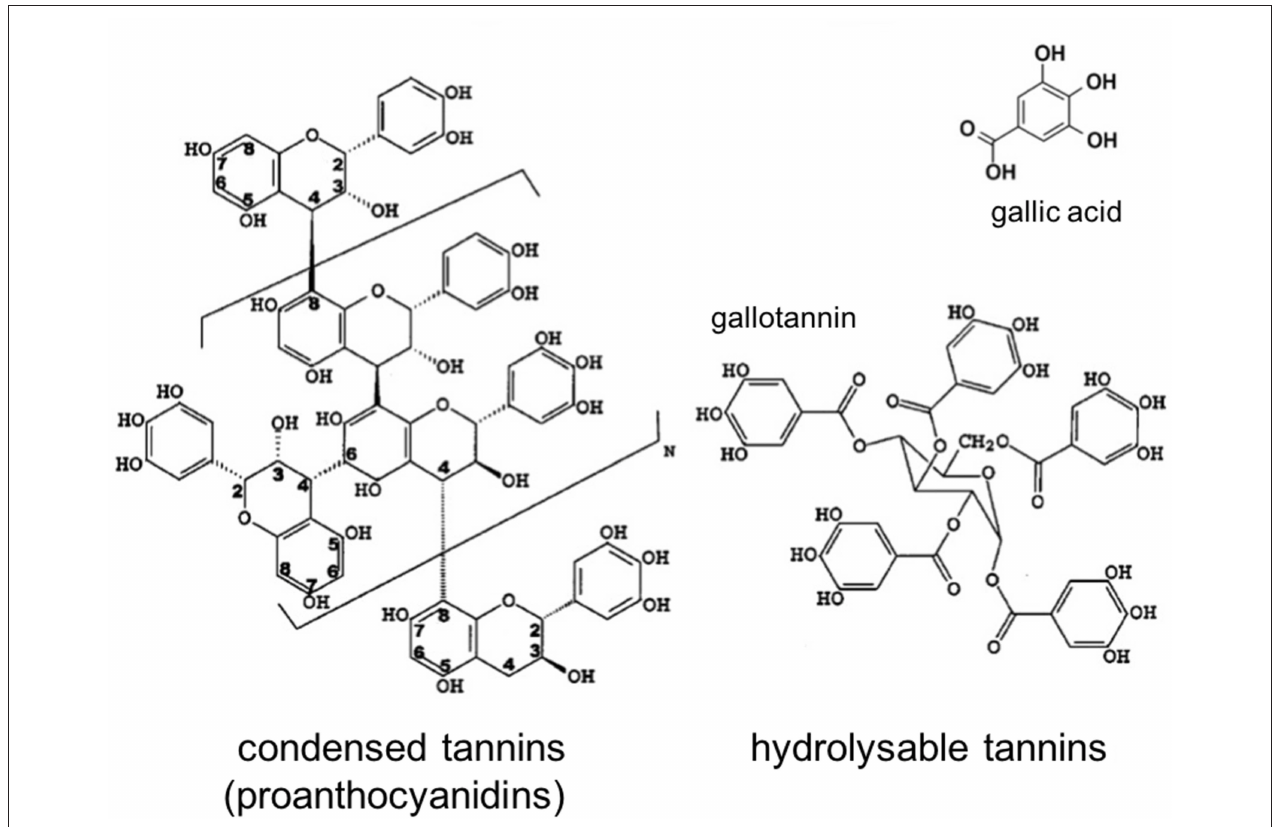
FIGURE 1 | Structure of condensed and hydrolysable tannins (modified after Hernes and Hedges,